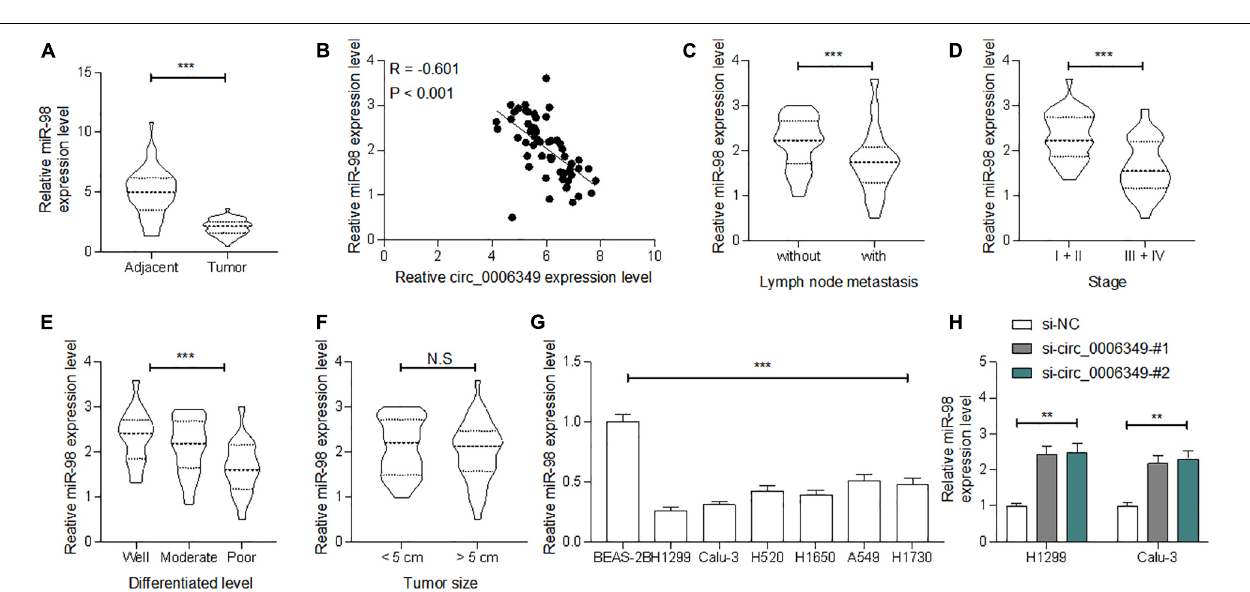
FIGURE 3 | Circ_0006349 sub-localizes in cytoplasm and binds to miR-98. (A,B) subcellular localization of circ_0006349 in Calu-3 and H1299 cells determined by nuclear-cytoplasmic RNA separation (A) and FISH (B) assays; (C) a Venn diagram for the intersection of screened out differentially expressed miRNAs from the GSE29250 dataset and the predicted target miRNAs of circ_0006349; (D) putative binding site between circ_0006349 and miR-98; (E,F) binding relationship between miR-98 and circ_0006349 validated through dual luciferase reporter gene and RIP assays. Differences were compared by two-way ANOVA (E,F) . All data were presented as the mean ± SD from three independent experiments. ** p <